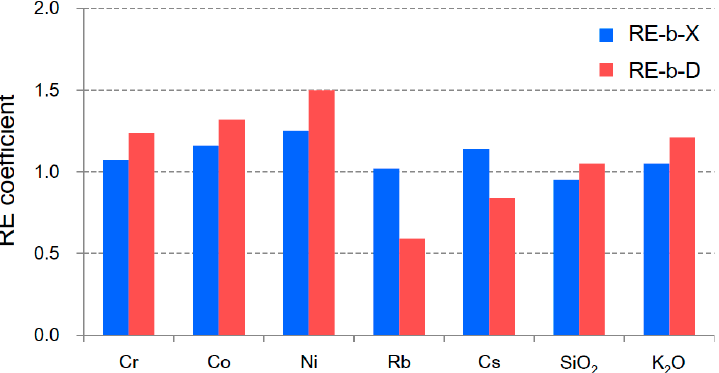
Figure 9. Average relative enrichment (RE) coefficient of selected elements (* f/b -X < 1 and * f(f)/b -D < 1; Table 6) in the bottom ashes from Xilaifeng (X) and Damo (D).